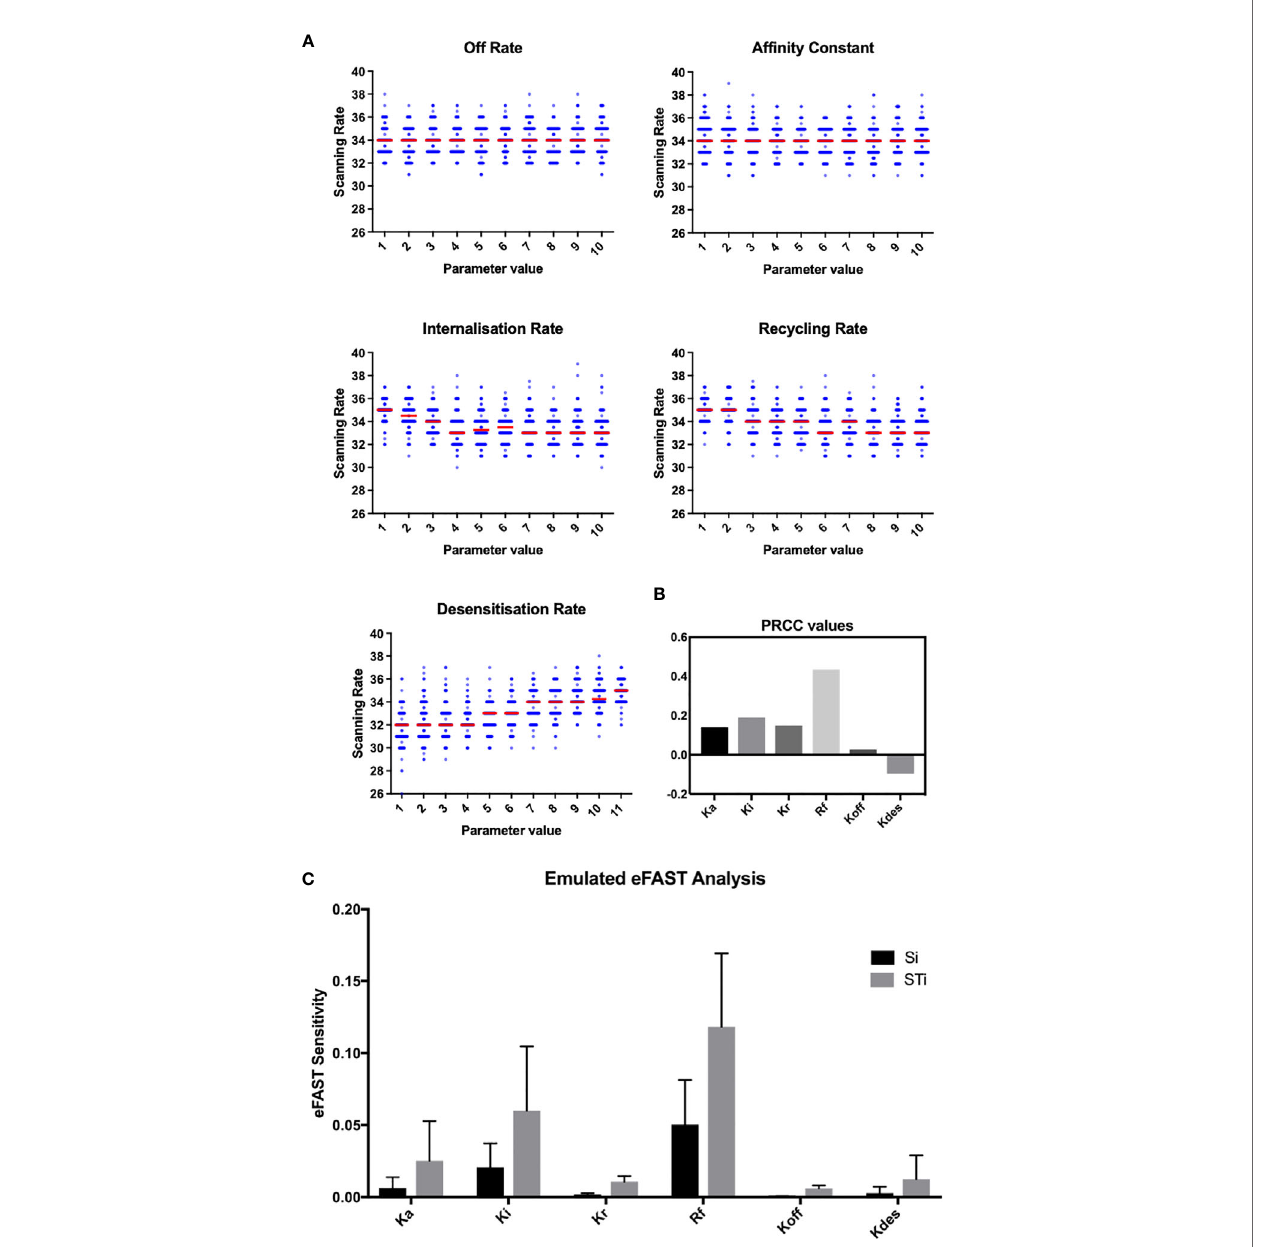
FIGURE 2 | OAT perturbation of kinetic parameters that regulate CXCR5 signaling. (A) Perturbing kinetic parameters regulating CXCR5 activity and assessing the effect on in silico scanning rates. (B) Partial rank correlation coef fi cients quantifying the sensitivity of in silico scanning rates to perturbations in a given parameter, taking the in fl uence of the other parameters into account. (C) eFAST analysis of parameter sensitivities using the CXCL13emulator Si (black) represents the fraction of output variance that can be explained by the value assigned to that parameter. STi (grey) represents the variance caused by higher order non-linear effects between that parameter and others explored. Bars represent the mean value for either Si or STi, with error bars representing the standard error over three resample